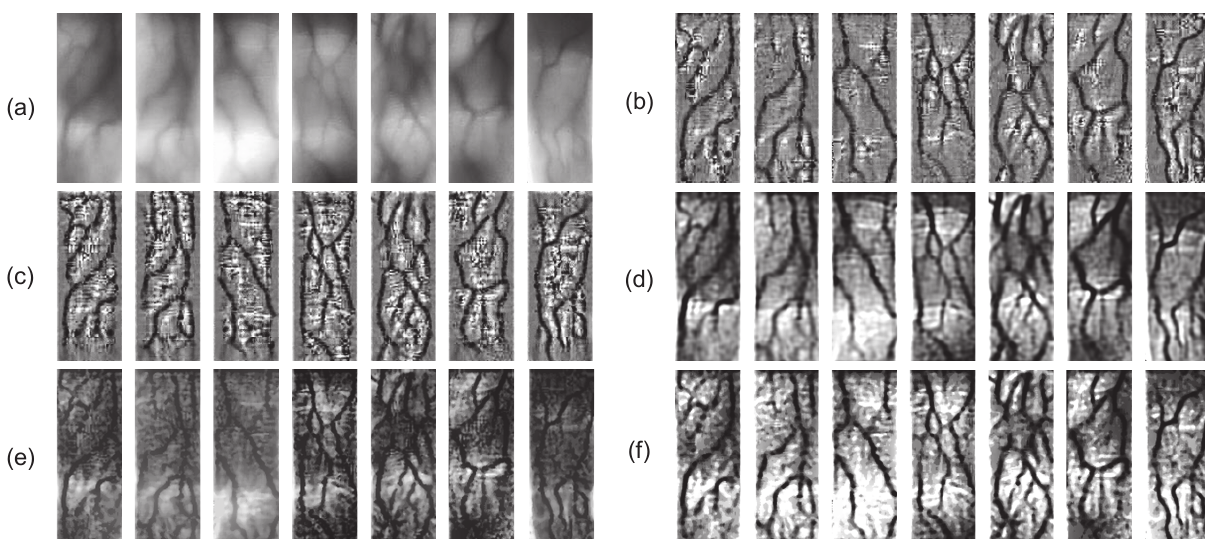
Figure 10. Comparisons with other methods. ( a ) Some captured finger-vein images. ( b ) The results from histogram template equalization (HTE) [5]. ( c ) The results from high frequency emphasis filtering (HFEF) [13]. ( d ) The results from circular Gabor filtering (CGF) [7]. ( e )